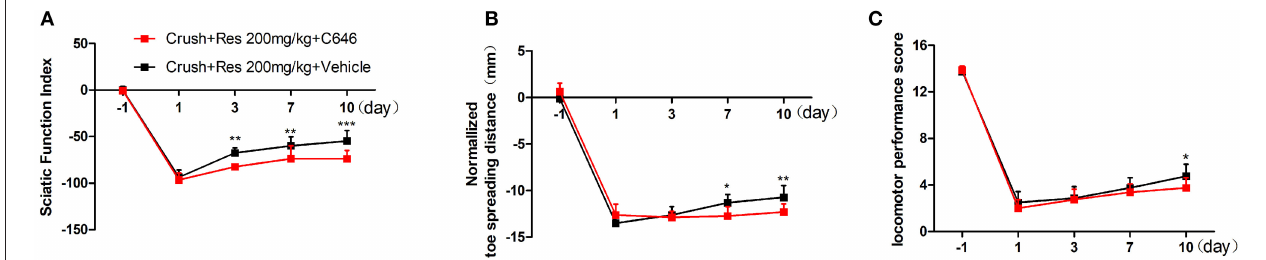
FIGURE 5 | The inhibition of p300 acetyltransferase activity abolished the effect of resveratrol (Res) on motor repair in crush injury rats. The intrathecal treatment of C646 reversed the Res-induced increase of the sciatic nerve index from the third to tenth days after the treatment (A) , the normalized toe spreading distance from the seventh to tenth days after the treatment (B) and the locomotor performance score on the tenth day after the treatment (C) (crush + 200 mg/kg Res vs. crush + 200mg/kg Res + C646, * P < 0.05 , ** P < 0.01 , *** P < 0.001 , n = 8 for each